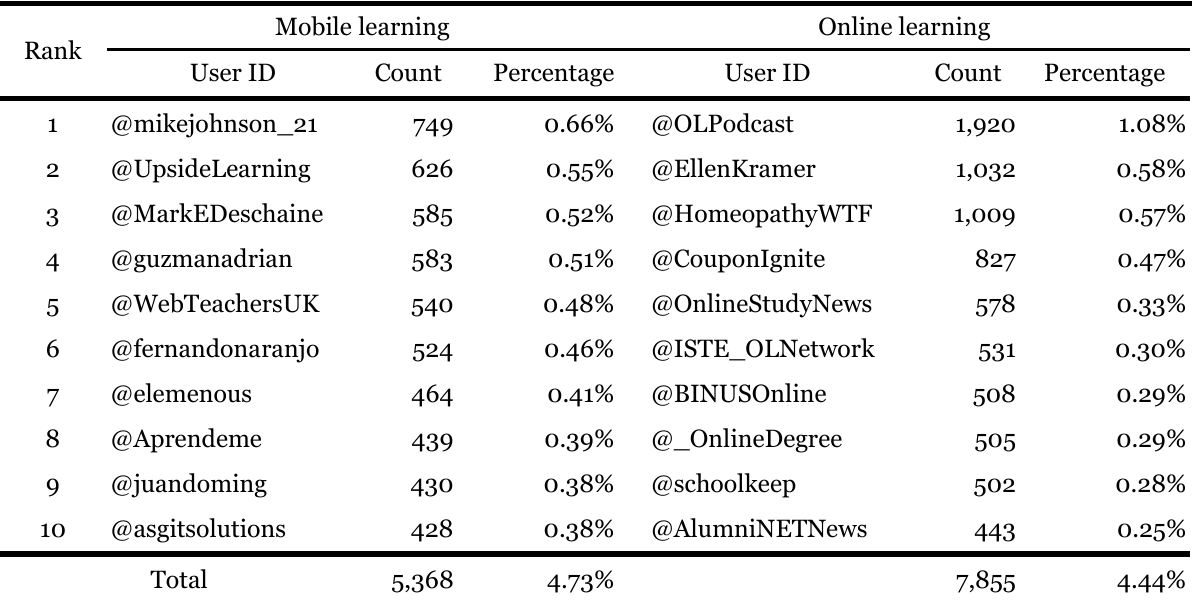
Top 10 Users by the Number of